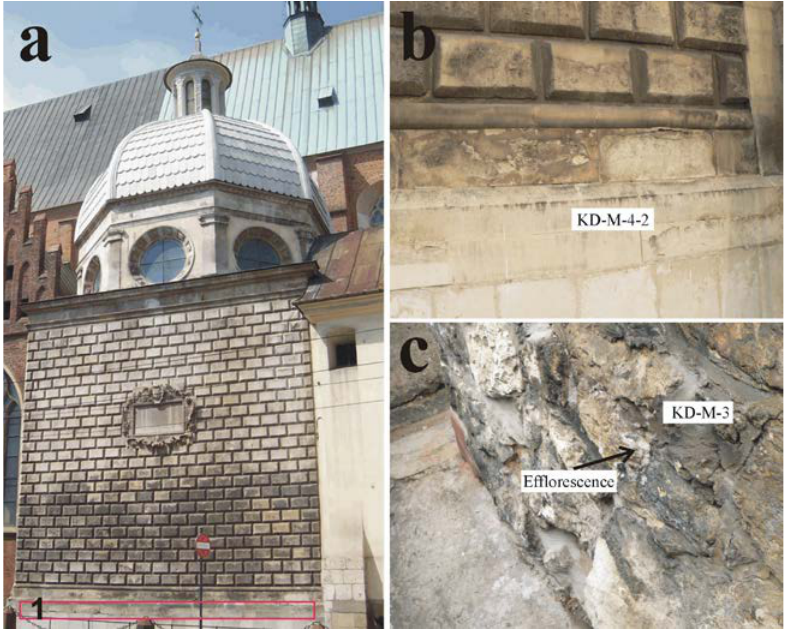
Figure 1. Myszkowskis Chapel of the Holy Trinity Church in Cracow ( a ) and sites of sampling: rusticated wall and elements beneath ( b ); exposed part of the foundations ( c ) (after [20], modified). The samples represent: KD-M-4-2—bright, cement rendered part of the elevation; KD-M-3—cement mortar from the subwall, in places covered with salt efflorescence. (1)—sampling area in detail in (b); area presented in (c) is located beneath the pavement level, below the area marked as (1). Photos (b) and (c) by K. Bałaga.